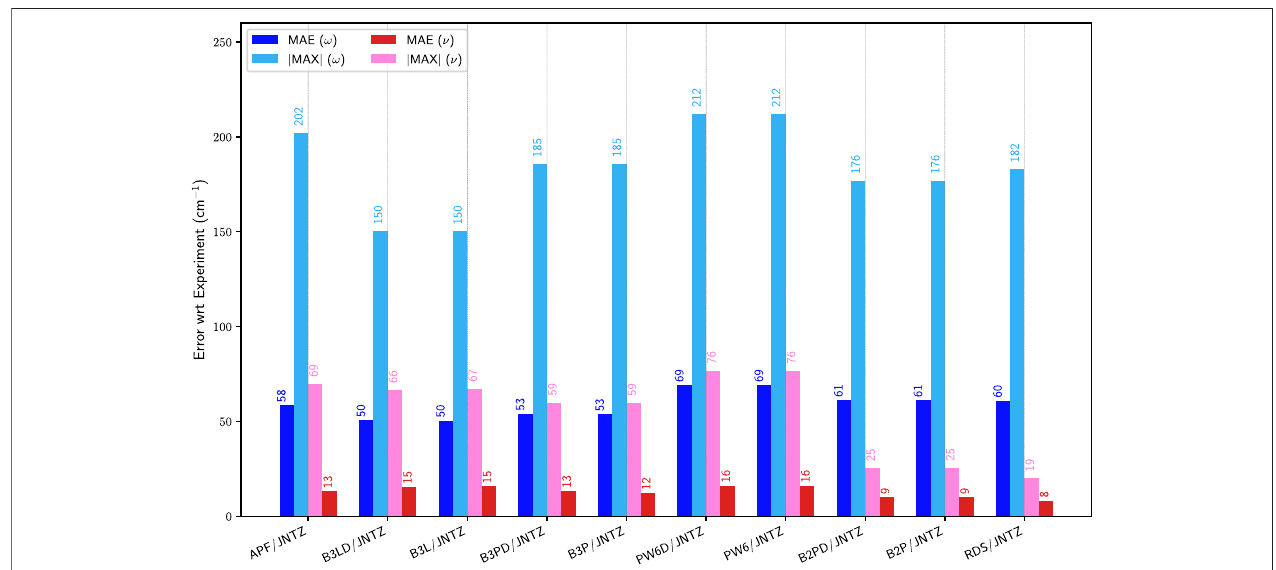
FIGURE2| Comparisonofthemean(MAE)andmaximumabsolute(|MAX|)errorsfordifferentfunctionalswiththejun-cc-pVTZ( JNTZ )basissetoverthe fi rstsetof molecules (G1): APF : APF, B3L : B3LYP, B3P : B3PW91, PW6 : PW6B95, B2P : B2PLYP, RDS : revDSD-PBEP86-D3(BJ). ω (blue) corresponds to the harmonic approximation, ν (pink/red) to GVPT2. The values are indicated on top ofthe bars. Reference experimental data taken from: water (Tennyson et al., 2001), H 2 S(Isoniemi et al., 1999), formaldehyde (Reisner et al., 1984), thioformaldehyde (Suzuki et al., 2007), ethylene (Nakanaga et al., 1979), 1,1-di fl uoroethylene (Krasnoshchekov et al., 2013), fl uoroethylene (Tasinato et al., 2006), 1- fl uoro-1-chloro-ethylene (Pietropolli Charmet et al., 2016).